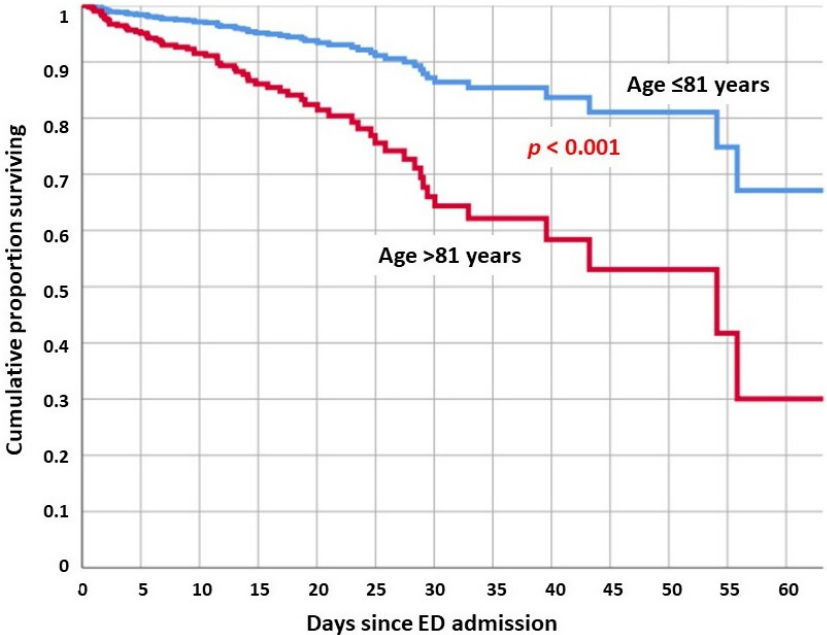
Figure 3. Adjusted cumulative survival of CDI patients according to age divided by the cutoff value of 81 years indicated by the ROC analysis Youden index (J). Adjusted mortality was about threefold higher in older patients regardless of comorbidities and other clinical covariates.